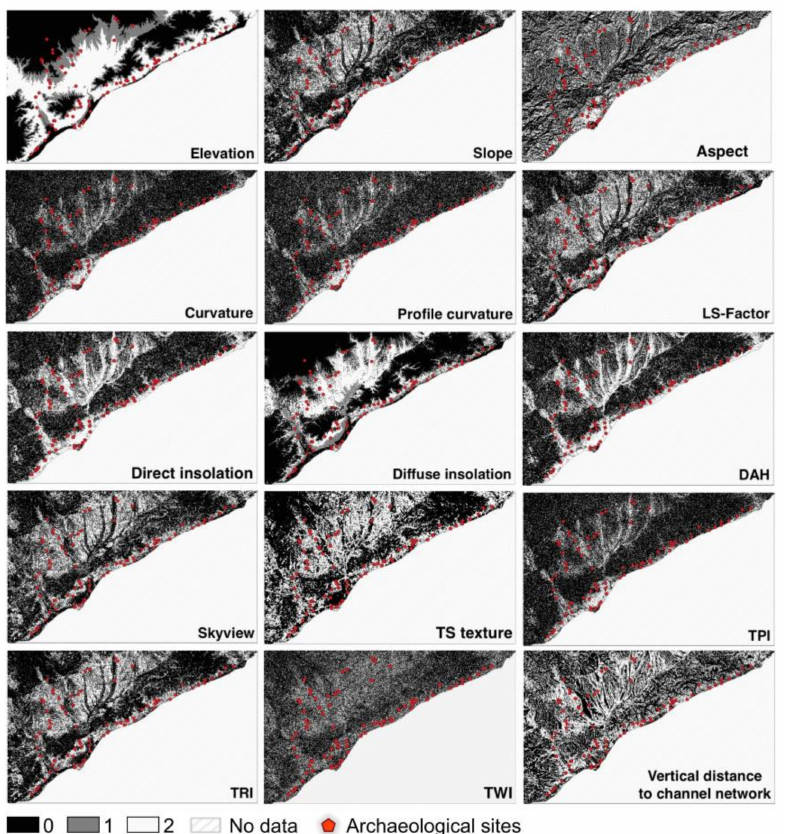
Figure 4. Rasters of the reclassified topographic predictor